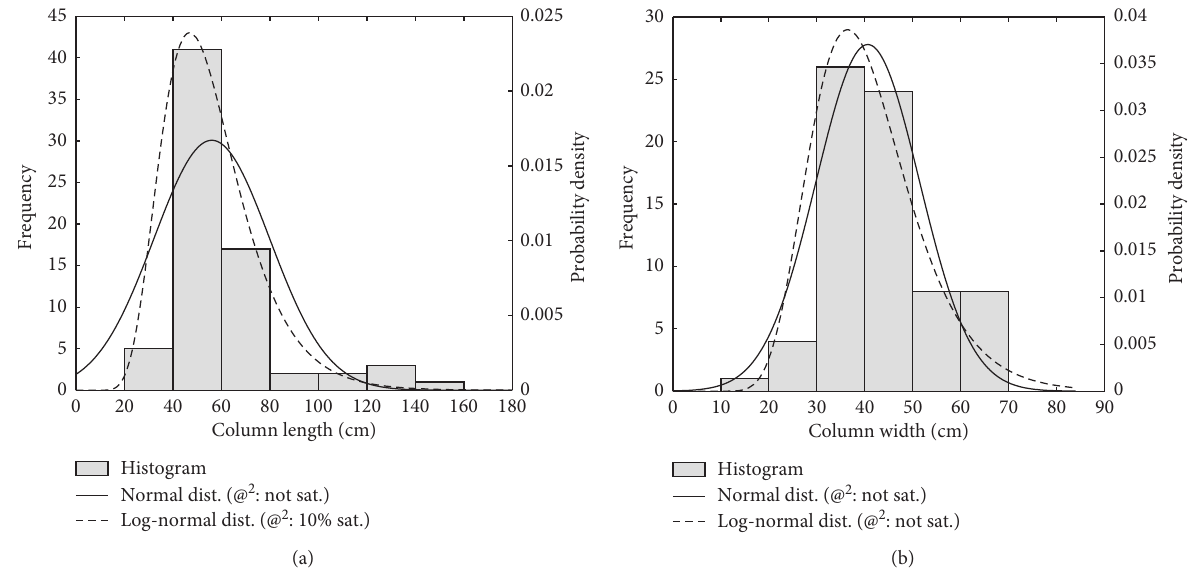
Figure 18: Histogram and probability distributions associated with the columns: (a) length and (b) width.